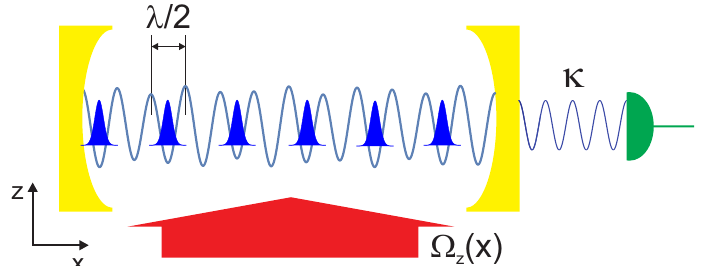
Figure 1: (color online) The Hubbard model we consider describes the dynamics of atoms in an optical lattice and interacting with the standing-wave mode of a high- finesse optical cavity. In the limit in which the atom-photon interactions are disper- sive and the cavity field can be adiabatically eliminated from the atomic dynamics, the resulting Hubbard model is characterized by all-to-all interactions mediated by the cavity photons. The trasverse arrow symbolizes an external laser pumping pho- tons into the cavity via coherent atom scattering. The additional disorder shifts the energy of the lattice potential. The quantum state of the system can be inferred by measuring the light at the cavity output, by time-of-flight measurements, or by Bragg spectroscopy using a weak